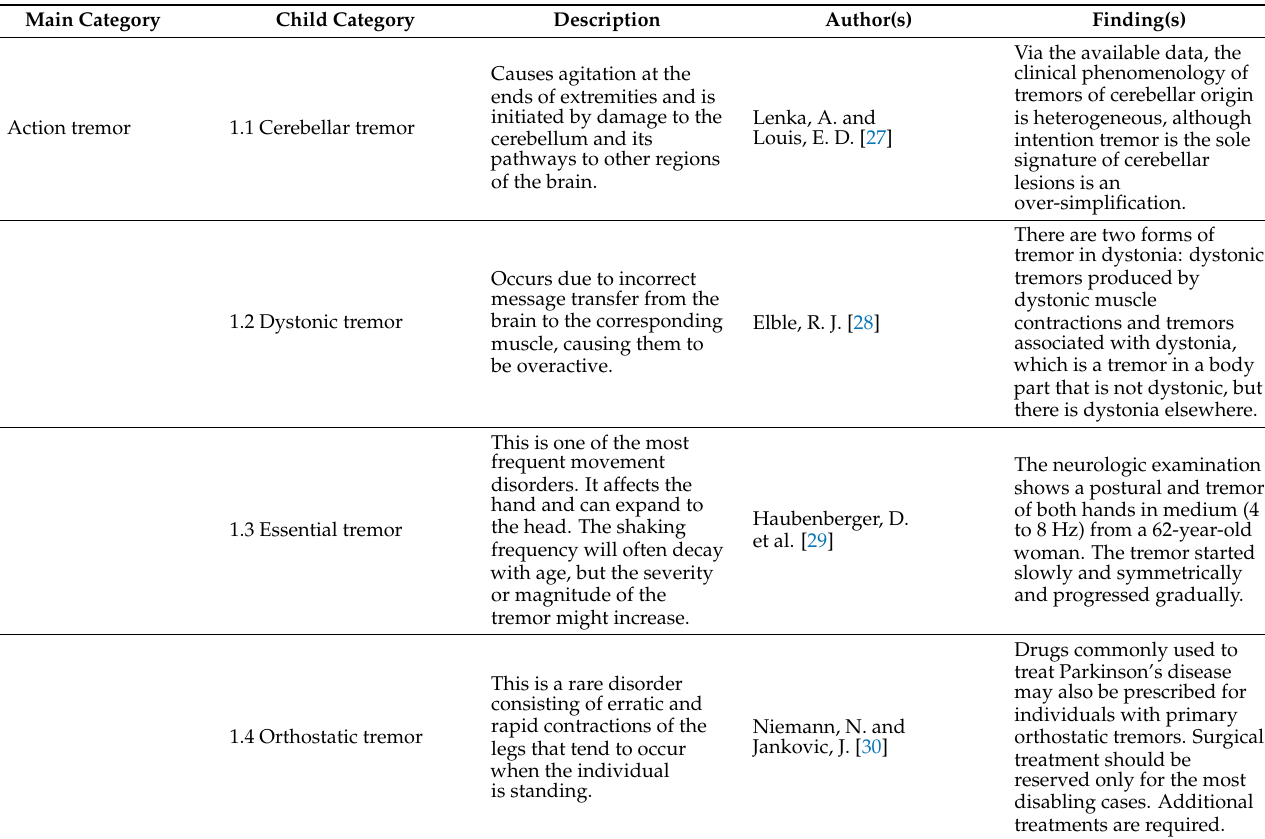
Table 1. Review of the clinical investigation of various kinds of